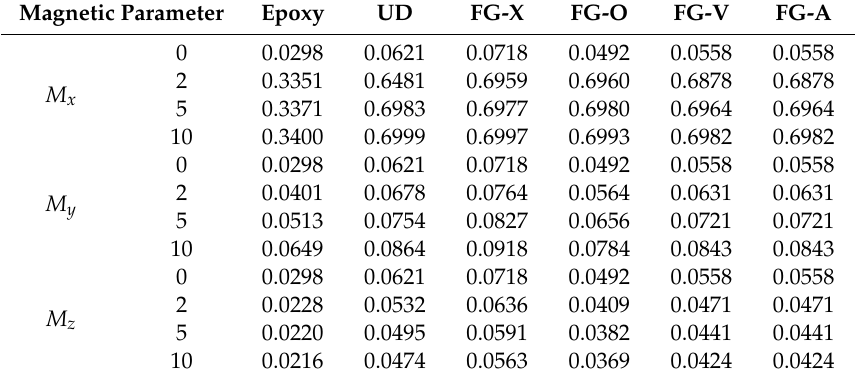
Table 6. The magnetic e ff ects on the fundamental frequency Ω of FG-GPLRC beams ( λ = 1 / 10, K w = K p = 0).